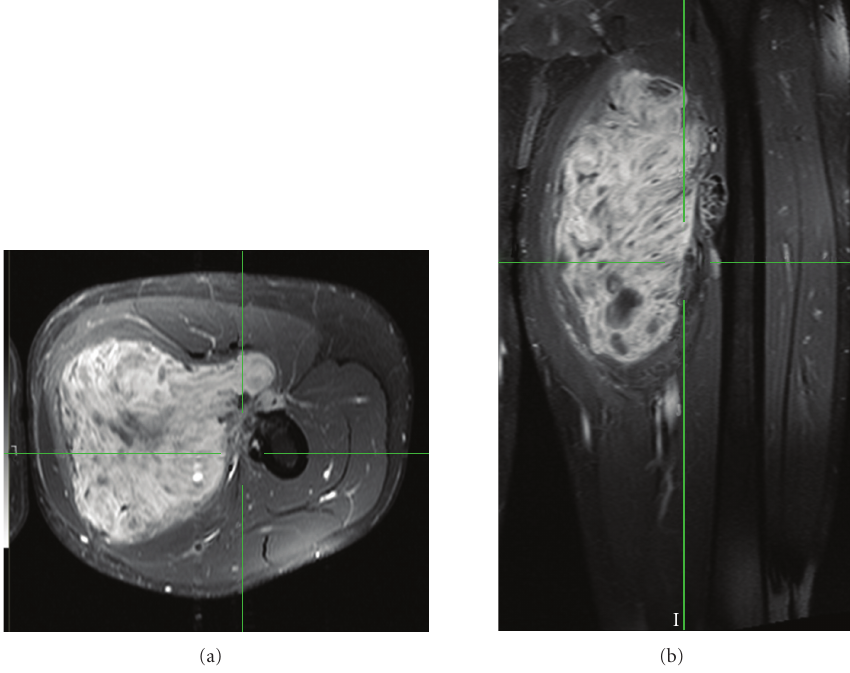
Figure 1: Axial (a) and coronal (b) magnetic resonance imaging scans of soft tissue sarcoma arising from the adductor muscle and invading the periosteum of the